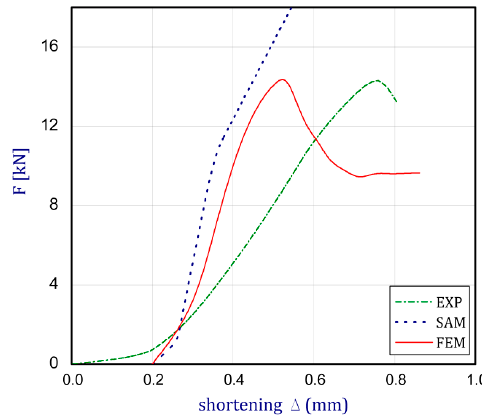
Figure 6. The diagram of the column compression (shortening vs. compressed force).